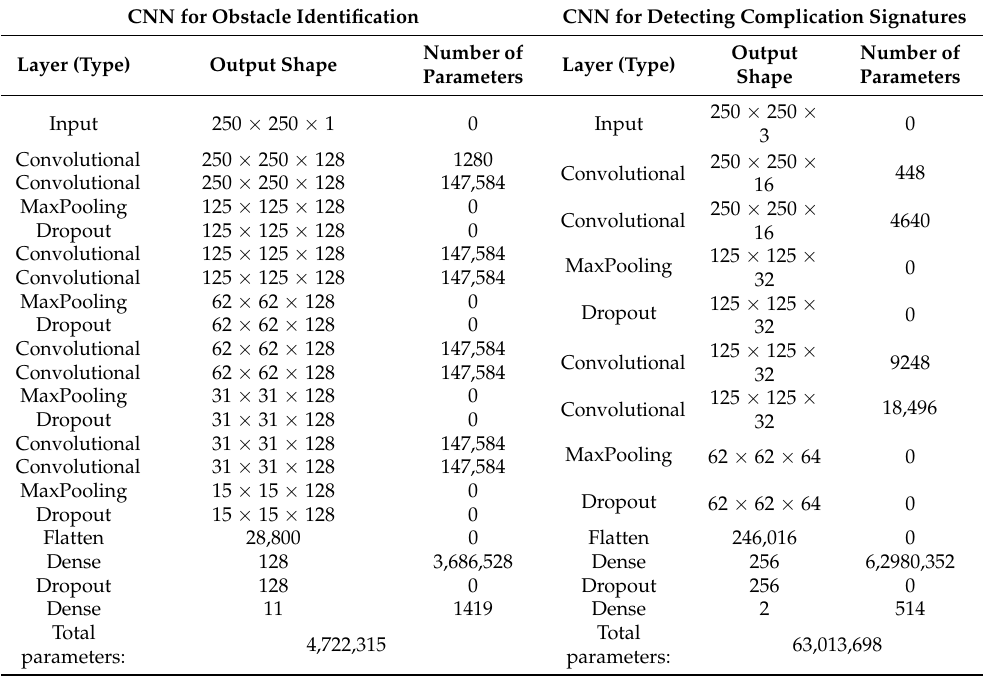
Table 5. Architectures of applied neural